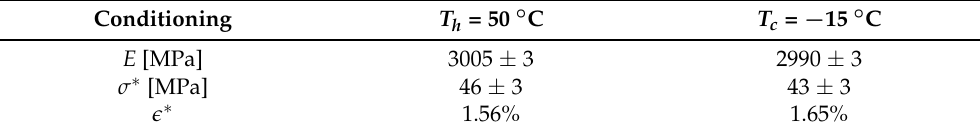
Table 5. Elastic characterization of thermally conditioned 0° specimens.